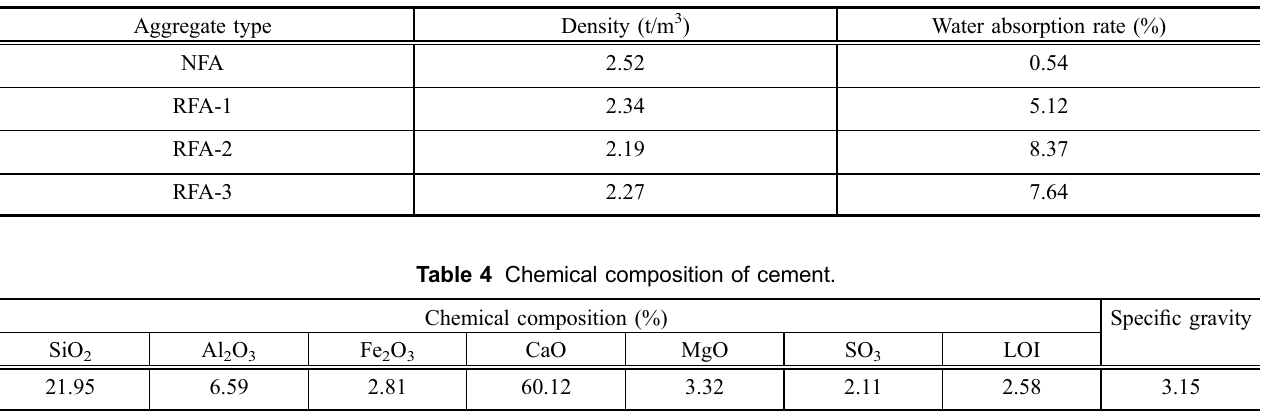
Table 3 Physical properties of fine aggregates.